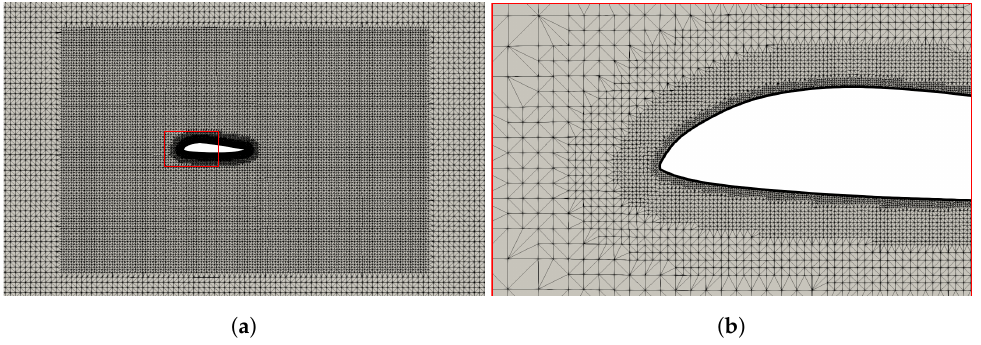
Figure 6. The computational mesh around the BWB aircraft. The red boxed area in ( a ) is magnified in ( b